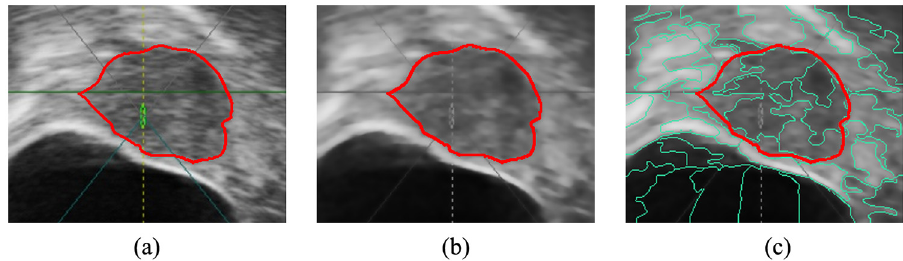
Fig 4. Splitting results. Red lines represent the tumor boundary depicted by the radiologist. (a) The original image. (b) The image after preprocess. (c) Superpixels.